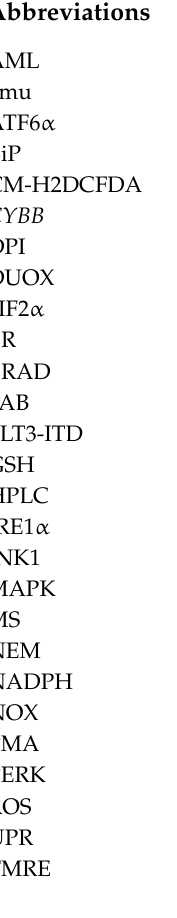
Figure S1: E ff ect of H 2 O 2 (100 µ M) supplementation on MV-4-11 cells incubated with VAS3947 at 4 µ M (n = 1), Figure S2: E ff ect of VAS3947 (4 µ M) on the expression of autophagy proteins in MV-4-11